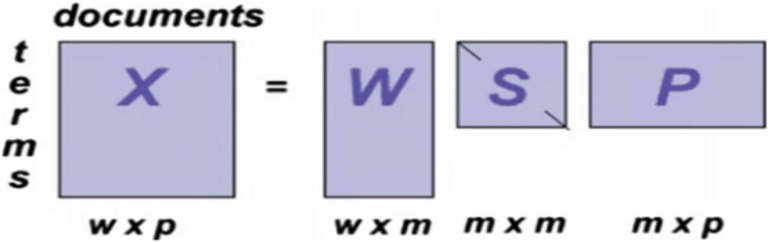
SVD of the LSA topic modeling method (Neogi et al., 2020).